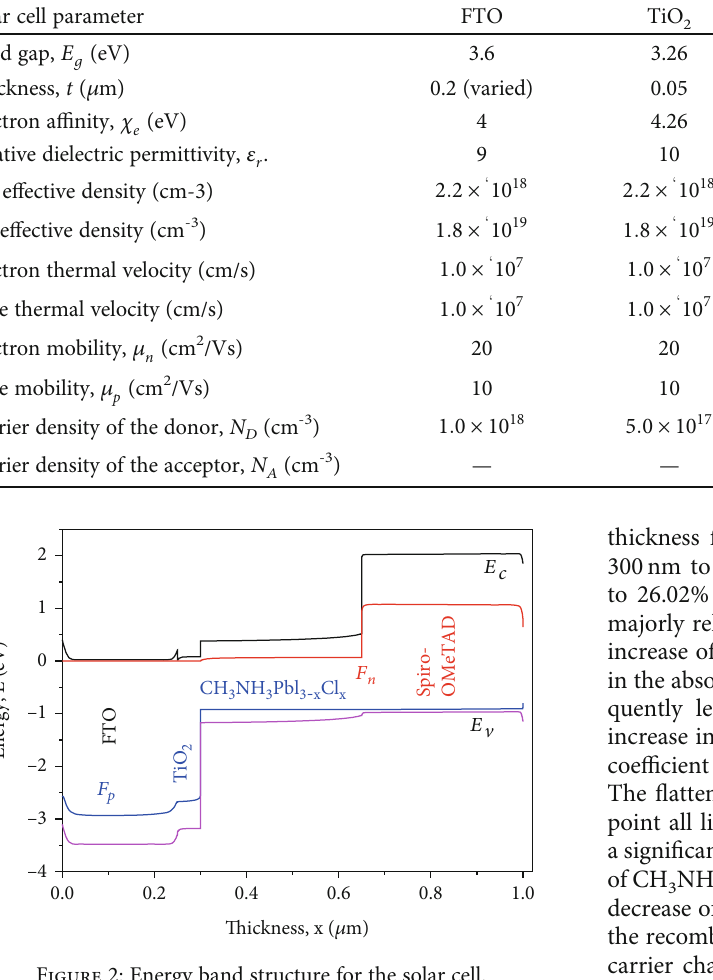
Figure 2: Energy band structure for the solar